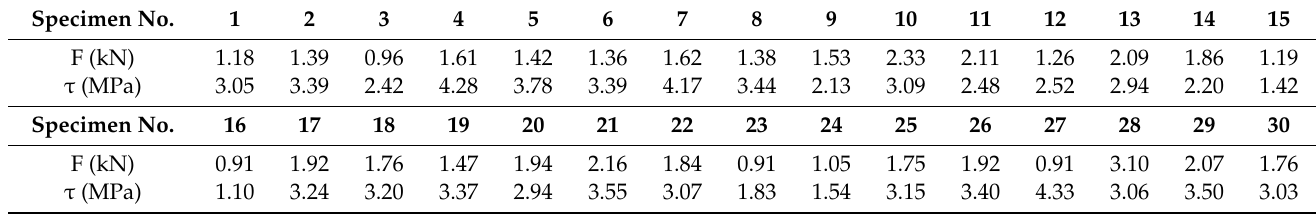
Table 7. First failure shear force (F) and shear stress ( τ